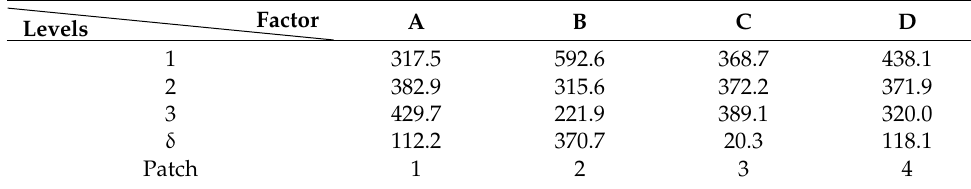
Table 6. Scratch track length average analysis.